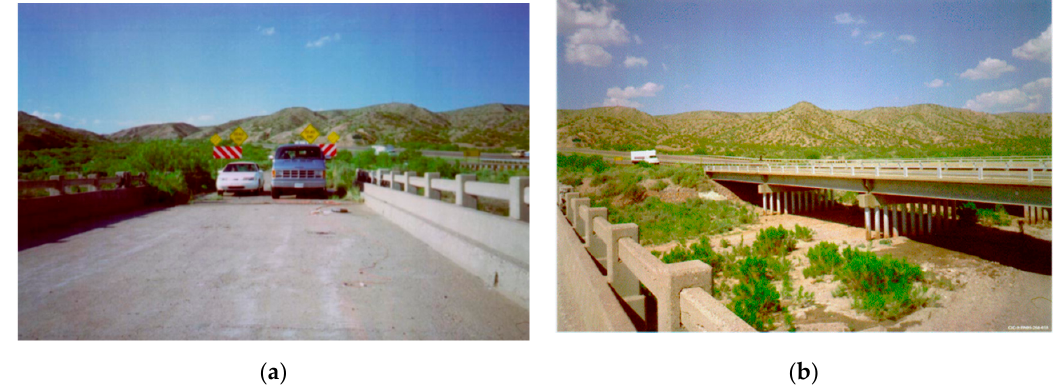
Figure 9. The ambient testing of the Alamosa Canyon Bridge. ( a ) Crossing of vehicles over the bridge. ( b ) Passing vehicle from the adjacent bridge [46].